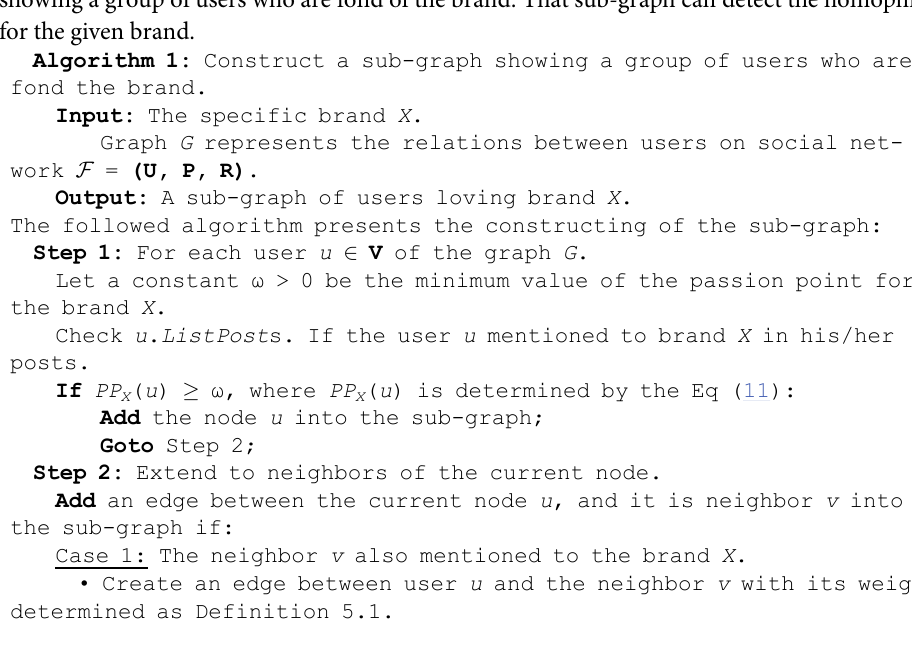
Algorithm 1: Construct a sub-graph showing a group of users who